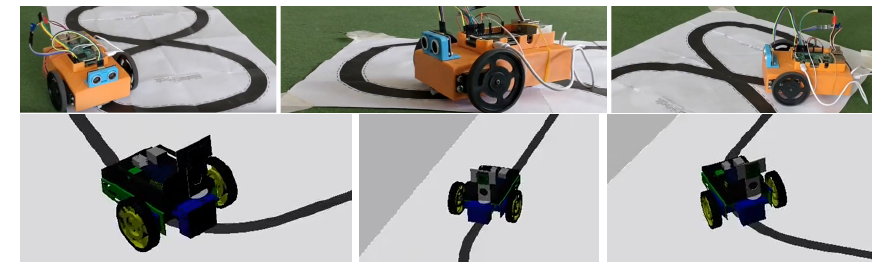
Figure 14. Practice line-tracking task in both real and simulated PiBot platforms using IR